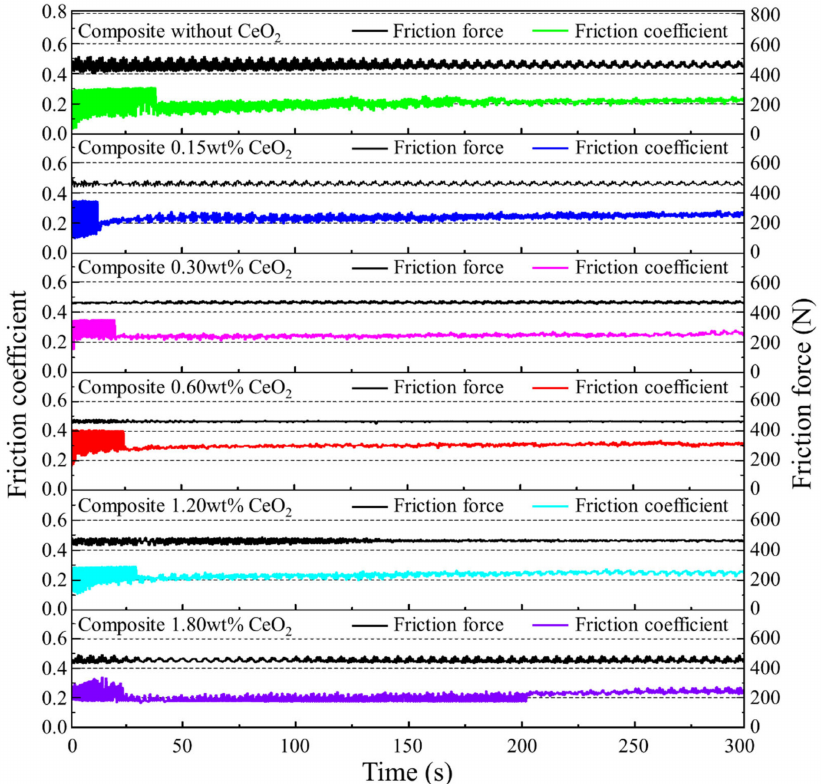
Figure 7. The curve of dynamic current-carrying friction coe ffi cient and friction force of SiCp / Al-Si Composites with di ff erent CeO 2